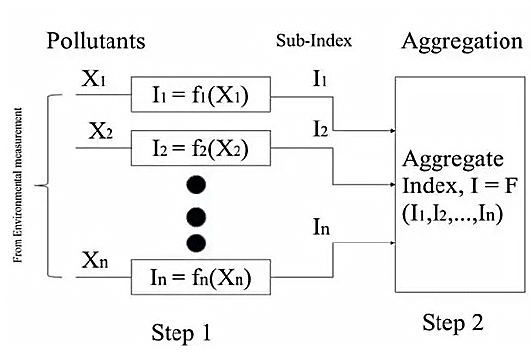
Fig. 2: Aggregated AQI formation Table 5: AQI of different station bases on summer season Station